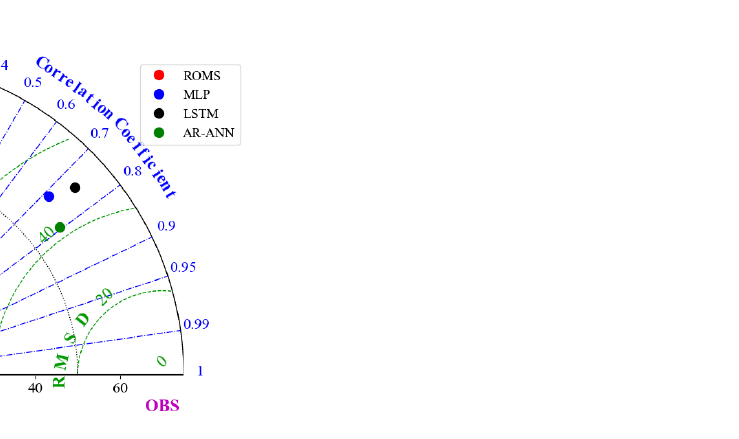
Figure 11. Taylor diagram for tidal current energy power density comparing estimation runs’ statistics for the R, RMSE, and STD of various